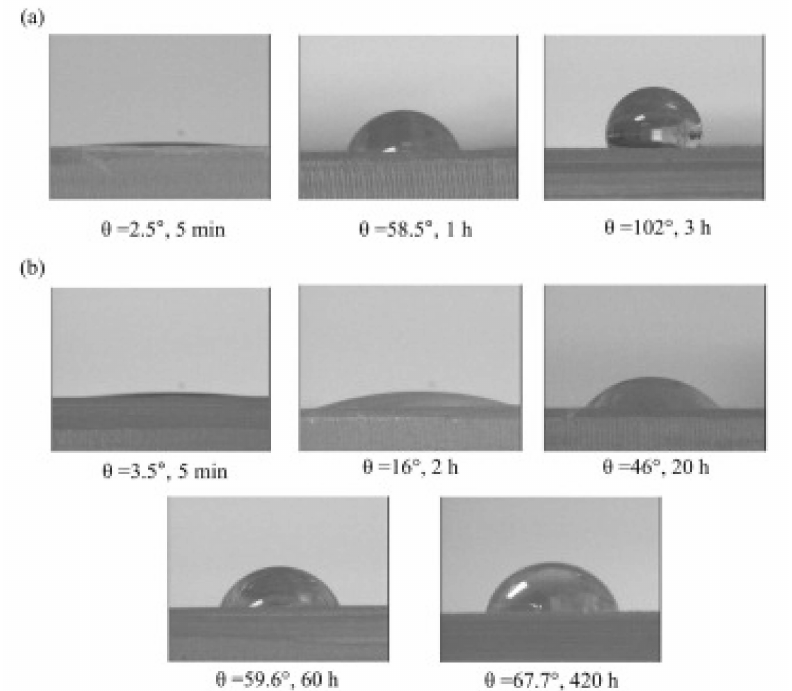
Figure 10. Optical micrographs of the contact angle of a DI water droplet on the PDMS substrate: ( a ) 5 min, 1 h, and 3 h after pure O 2 -plasma treatment; ( b ) 5 min, 2 h, 20 h, 60 h, and 420 h after O 2 -plasma-PEG